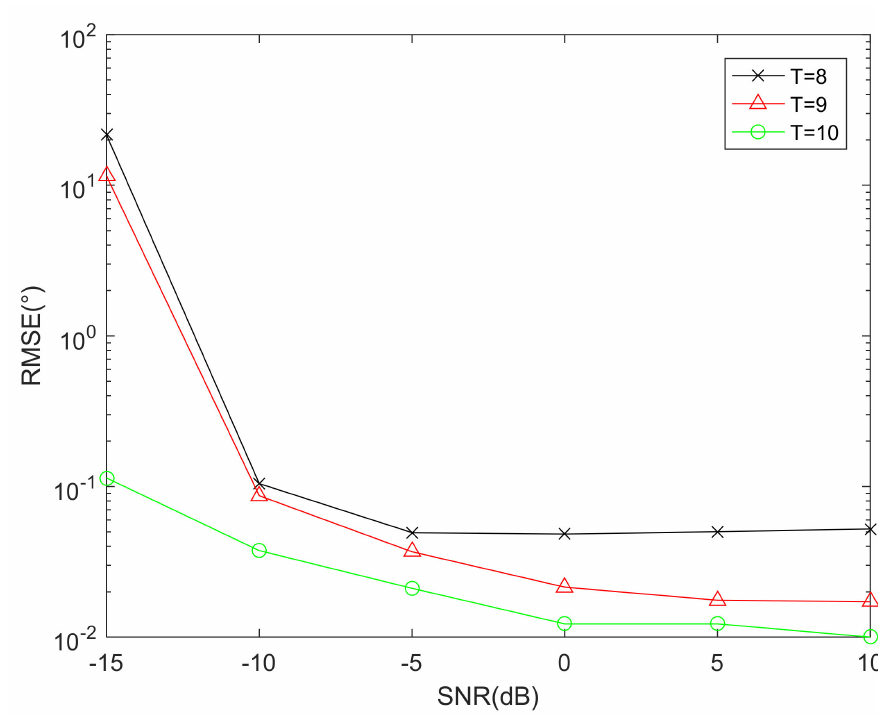
Figure 7. RMSE performance comparison versus sensors.